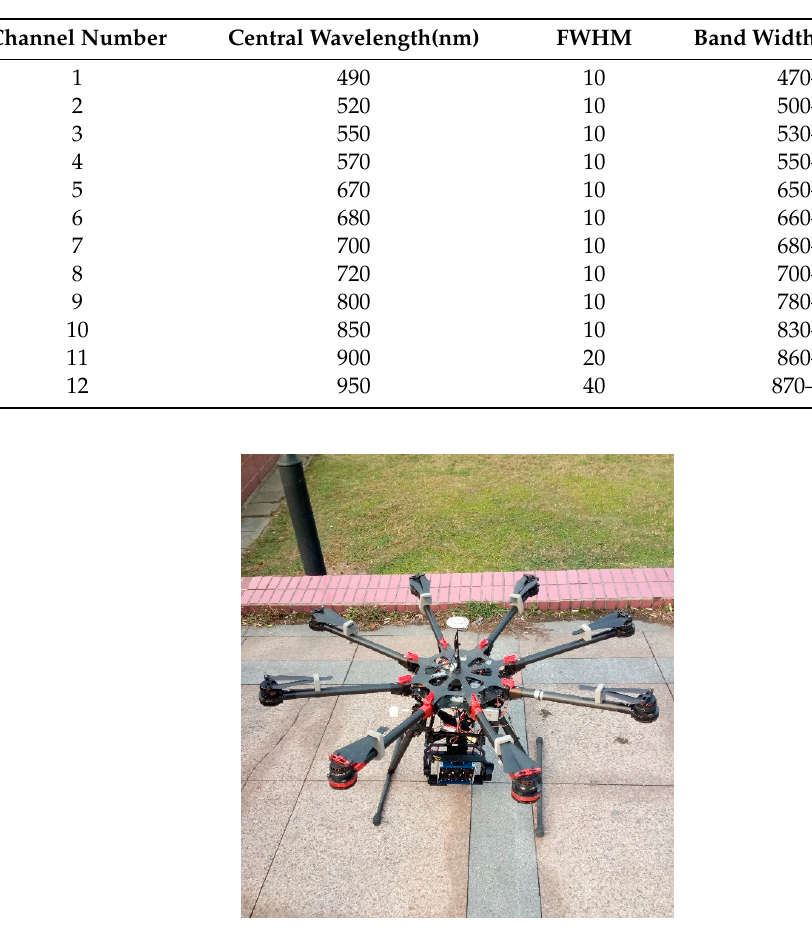
Figure 3. The spectral response of filters. Table 2. Characteristics of the twelve channels.